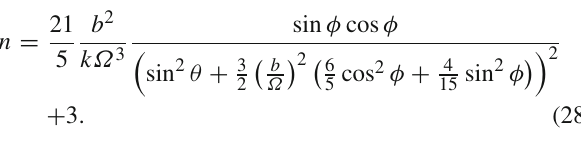
Fig. 5 The braking indices are functions of magnetic inclination angle θ for fixed acceleration b , moment of inertia and magnitude of magnetic dipole and φ . The accelerations of pulsars are vertical to direction of rotation